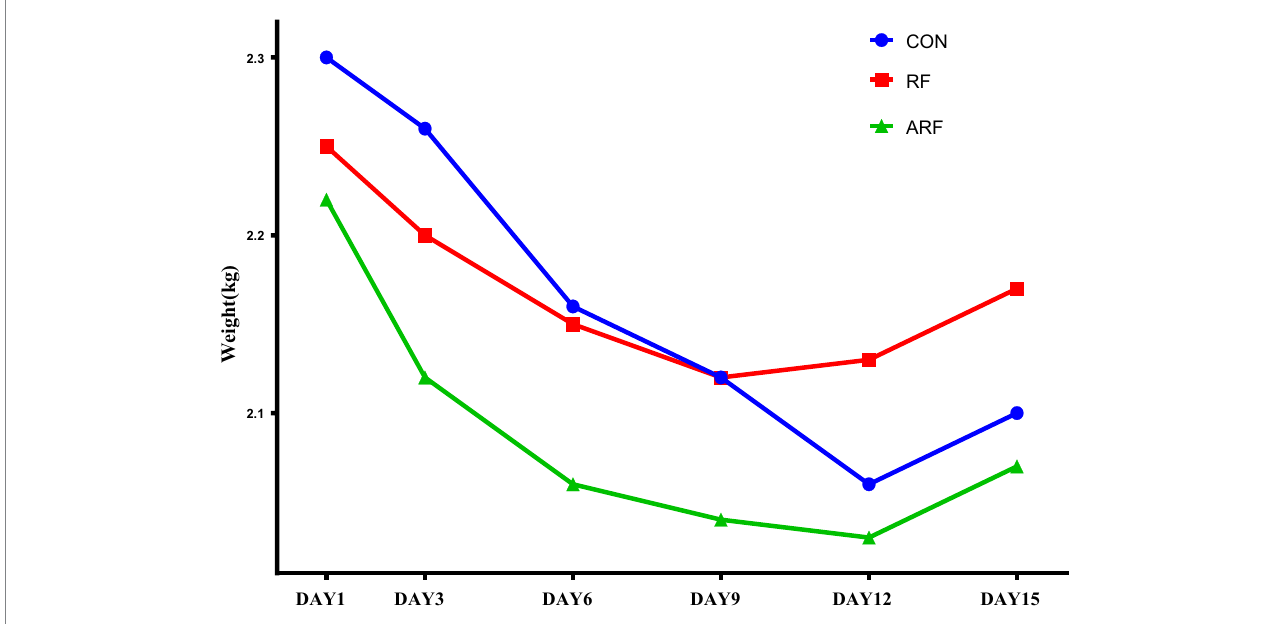
FIGURE 1 Trend of body weight change during postnatal 15 days in lambs inoculated with ruminal fluid (RF), autoclaved ruminal fluid (ARF) or sterilized physiological saline